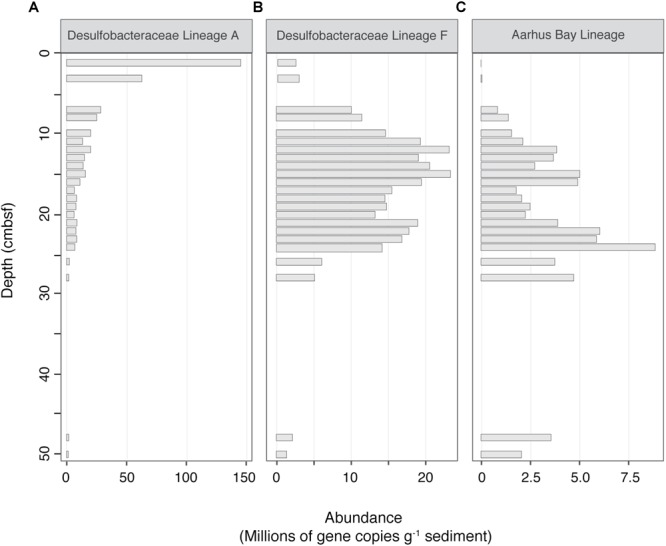
Absolute abundance profiles of three selected SRM lineages, representing three prominent population trends with depth. (A) Desulfobacteraceae Lineage A, declining with depth (B) Desulfobacteraceae Lineage F, clear maximum in the SR zone (C) Aarhus Bay Lineage, increasing with depth. Absolute abundances were estimated by multiplying sequence percent abundances by dsrB gene copy numbers, as determined by qPCR. Blank spaces indicate a lack of sequencing data.